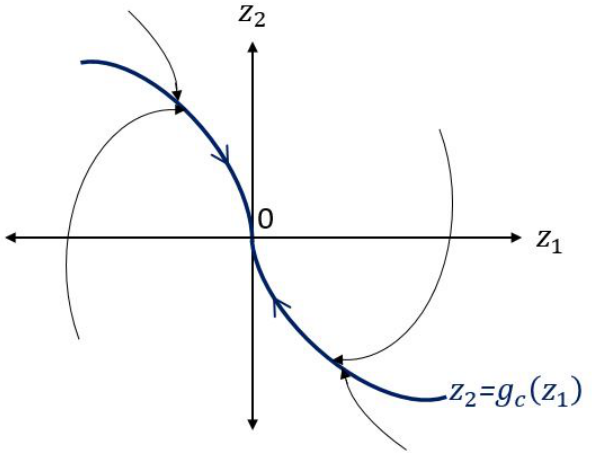
Figure 10. Phase trajectories of HO-PCL